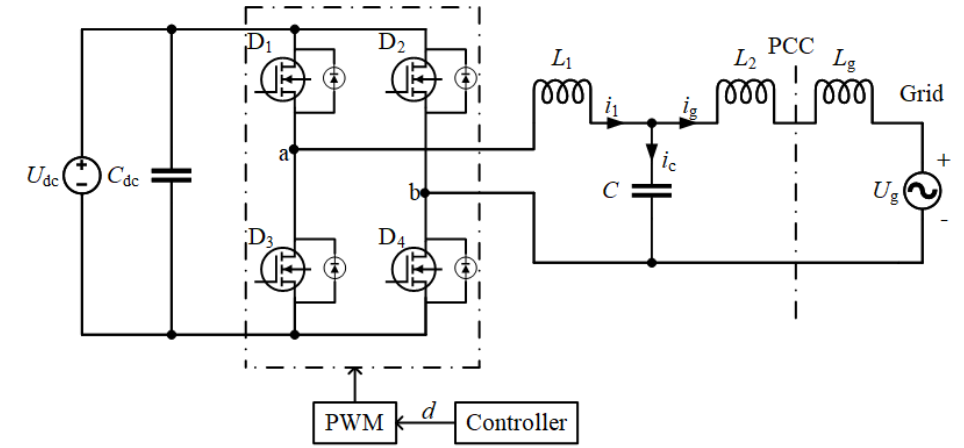
Figure 1. Single-phase LCL grid-connected